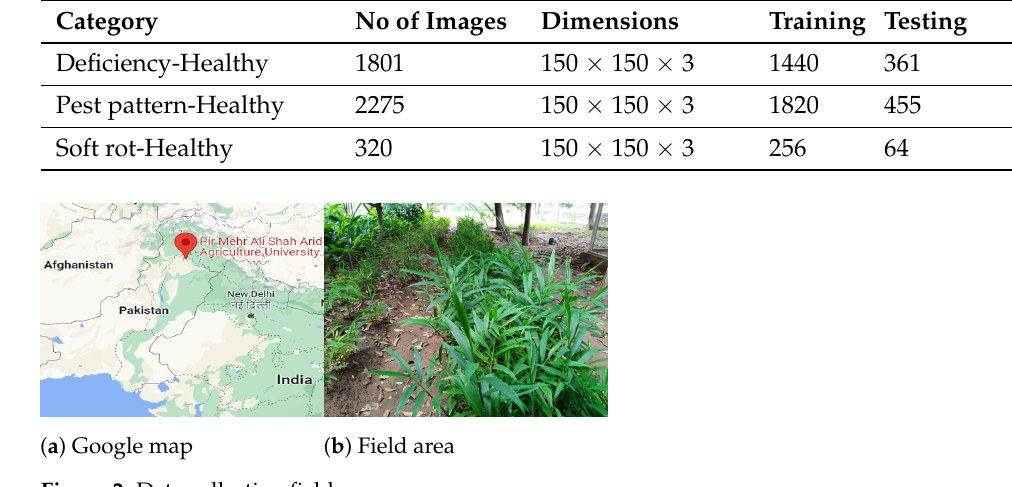
Figure 2. Data collection